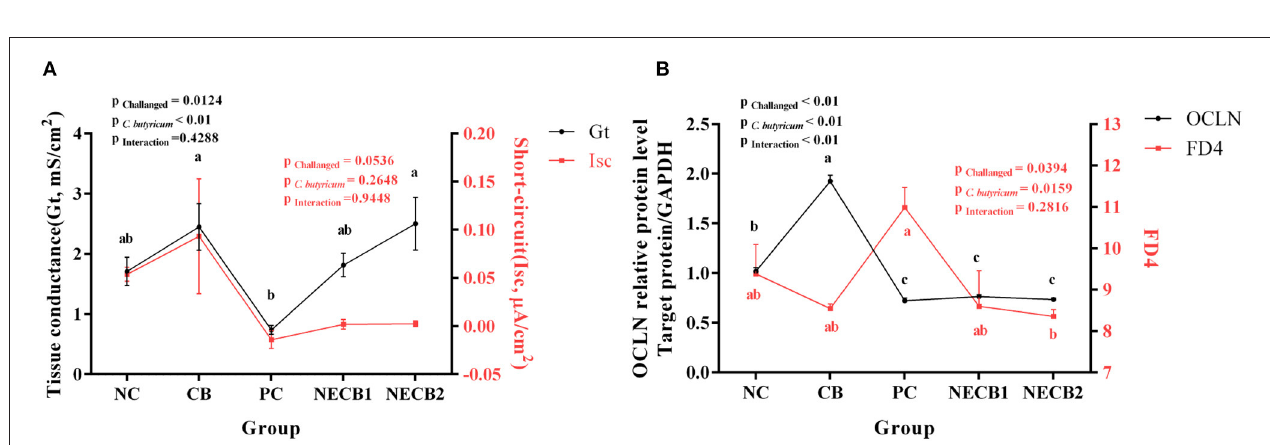
FIGURE 7 | Ussing chamber experiment results. (A) Changes in short-circuit current (Isc) and conductance (Gt). (B) OCLN expression level and FD4 flux. Each result represents the mean ± SEM ( n = 3). The different lowercase letters on the lines indicate significant differences ( p < 0.05).